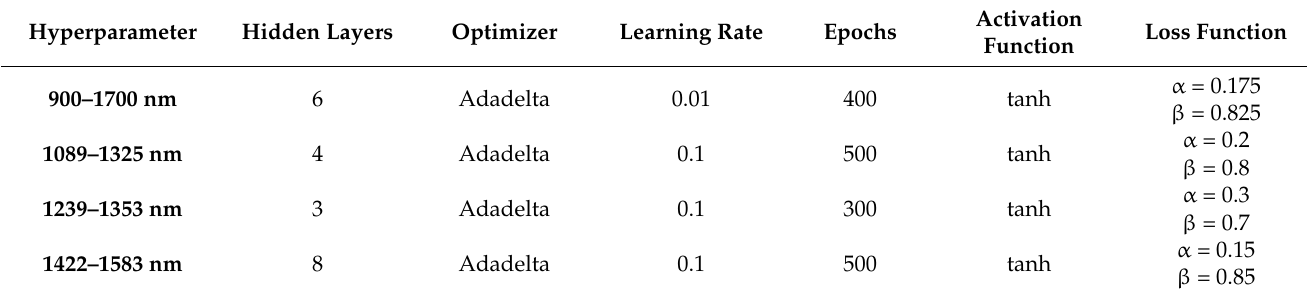
Table 6. The hyperparameters selected after the proposed tuning methodology.